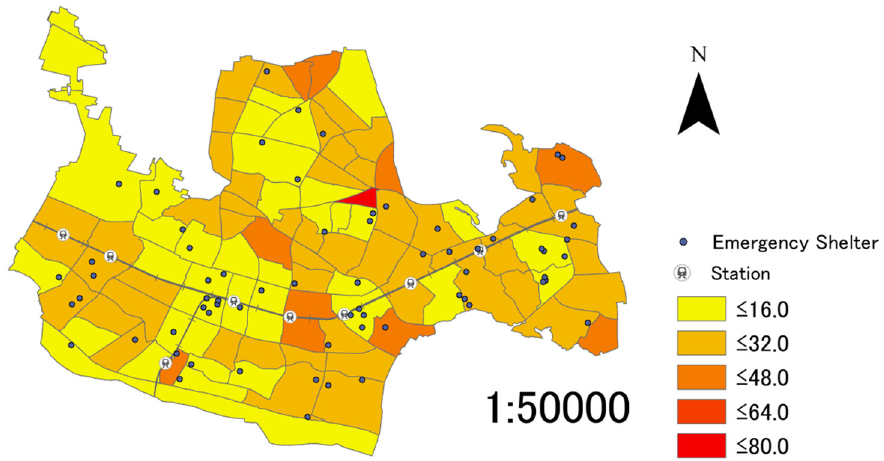
Figure 5. Result for Chofu City with the specialization coefficient of population density as a weighted coefficient.